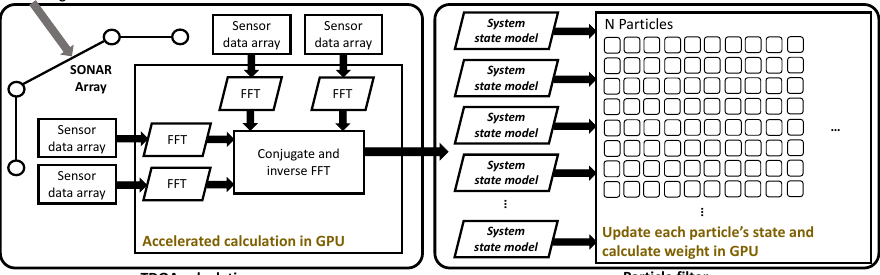
Figure 1. Proposed GPU based accelerated algorithm.